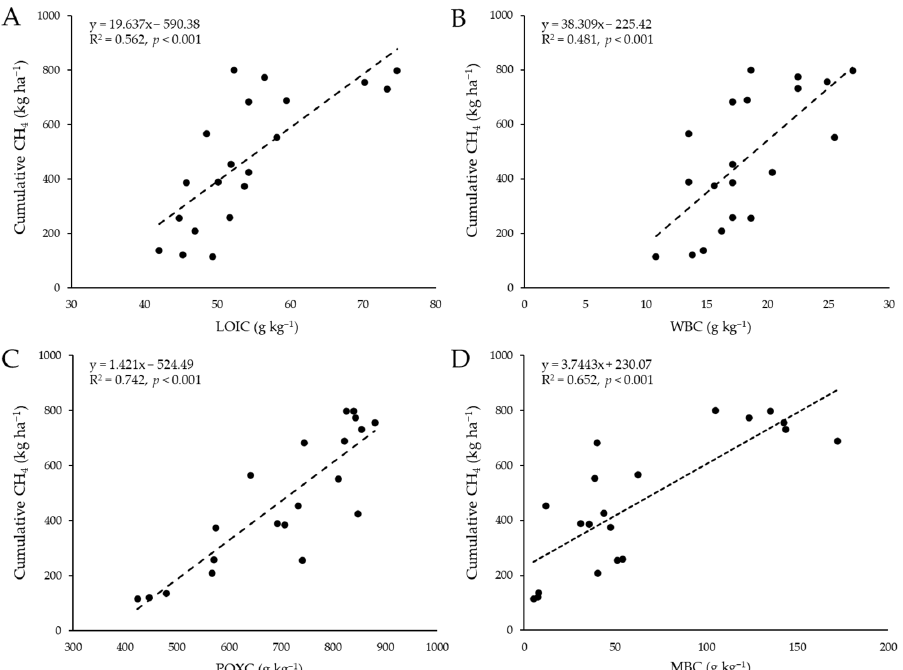
Figure 3. Linear regression relationship of cumulative methane (CH 4 ) emission with different SOC fractions, including LOIC ( A ), WBC ( B ), POXC ( C ), and MBC ( D ).